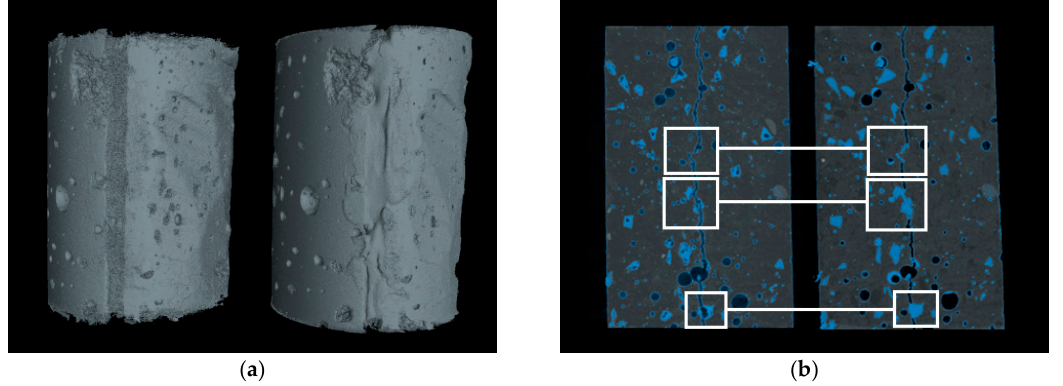
Figure 6. Reconstructed XCT images of ( a ) samples with WSRPs embedded cement mortar and ( b ) samples before and after sealing of the crack by WSRPs (blue particles). The length of scale bar in images is 10 mm.